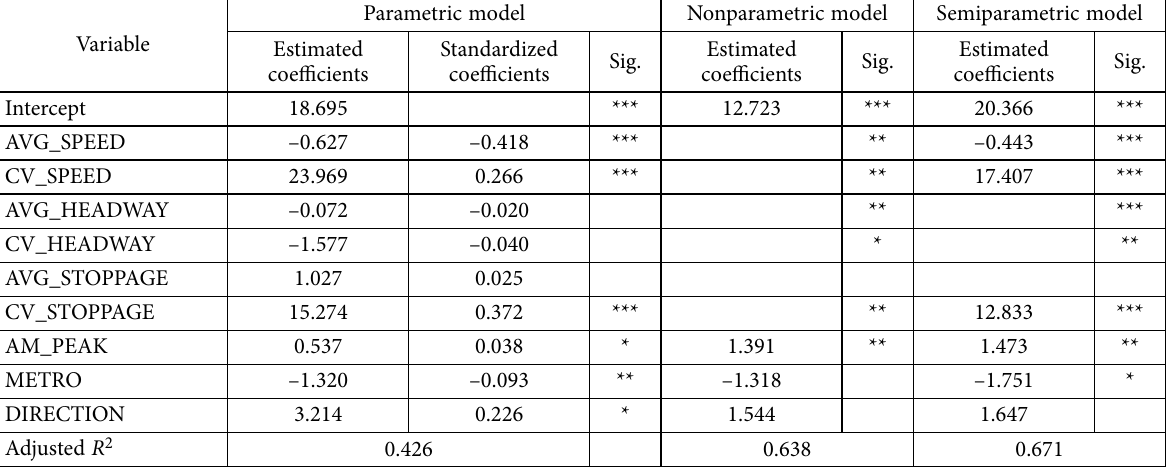
Table 3. Results of the parametric, nonparametric and semiparametric